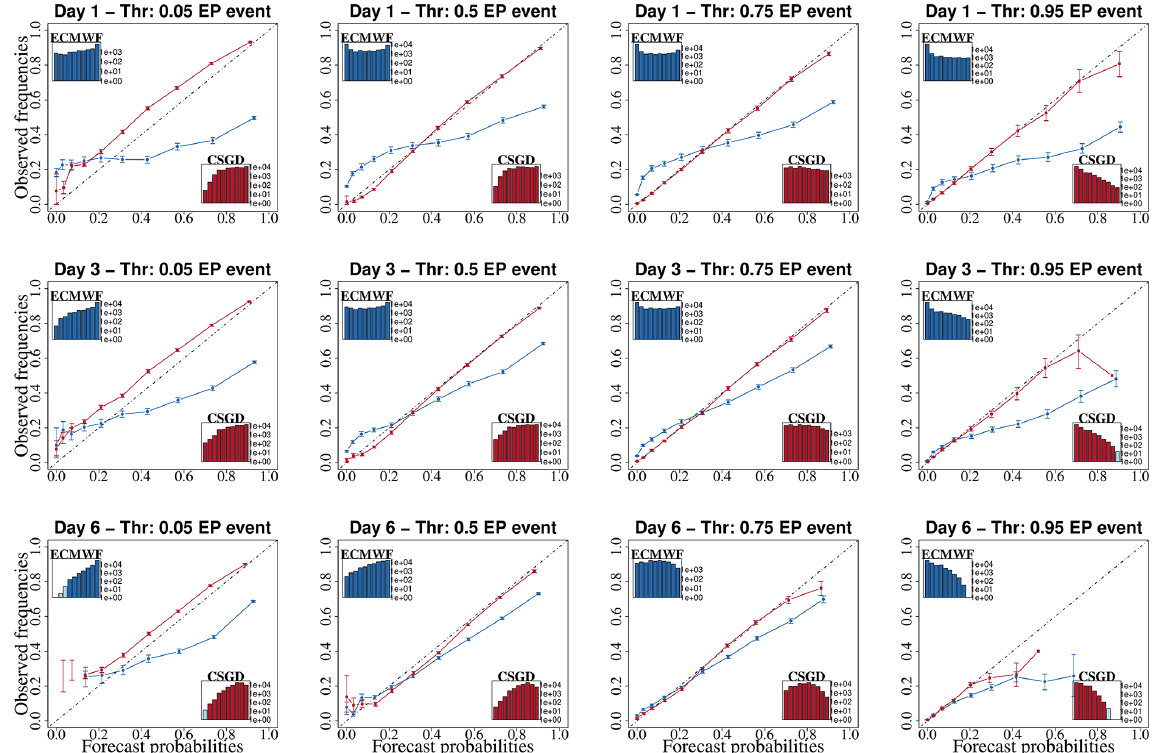
Figure 5. Reliability diagrams of raw (blue) and CSDG post-processed (red) precipitation forecasts for lead times of 1, 3, and 6d and different exceedance probability (EP) thresholds ( > 0 . 05 , 0 . 5 , 0 . 75, and 0 . 95 quantile of observations), calculated over the evaluation period (2011– 2016). The lines correspond to the median curve of all 30 catchments. The bars indicate 90% confidence intervals of observed frequencies from bootstrap resampling. The inset histograms depict the frequencies with which the category was